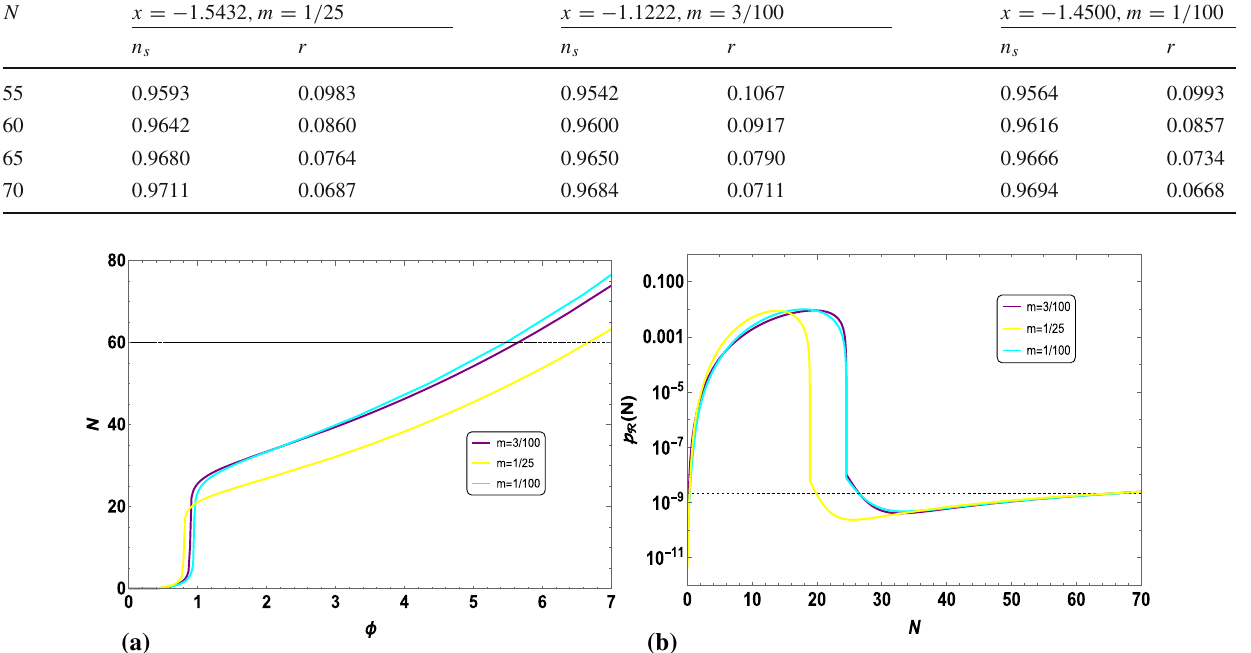
Fig. 4 Left panel: three different colors correspond to three differ- ent values of potential parameter x . Purple color corresponds to x = − 1 . 1222, cyan is for x = − 1 . 45 and yellow stands for x = − 1 . 5432. The number of e-folds ( N ) as a function of the scalar field ( φ ). The dot- ted black line corresponds to the N = 60. Right panel: the scalar power spectrum as a function of Number of e-folds ( N ). Three different colors correspond to three different values of potential parameter x . Purple